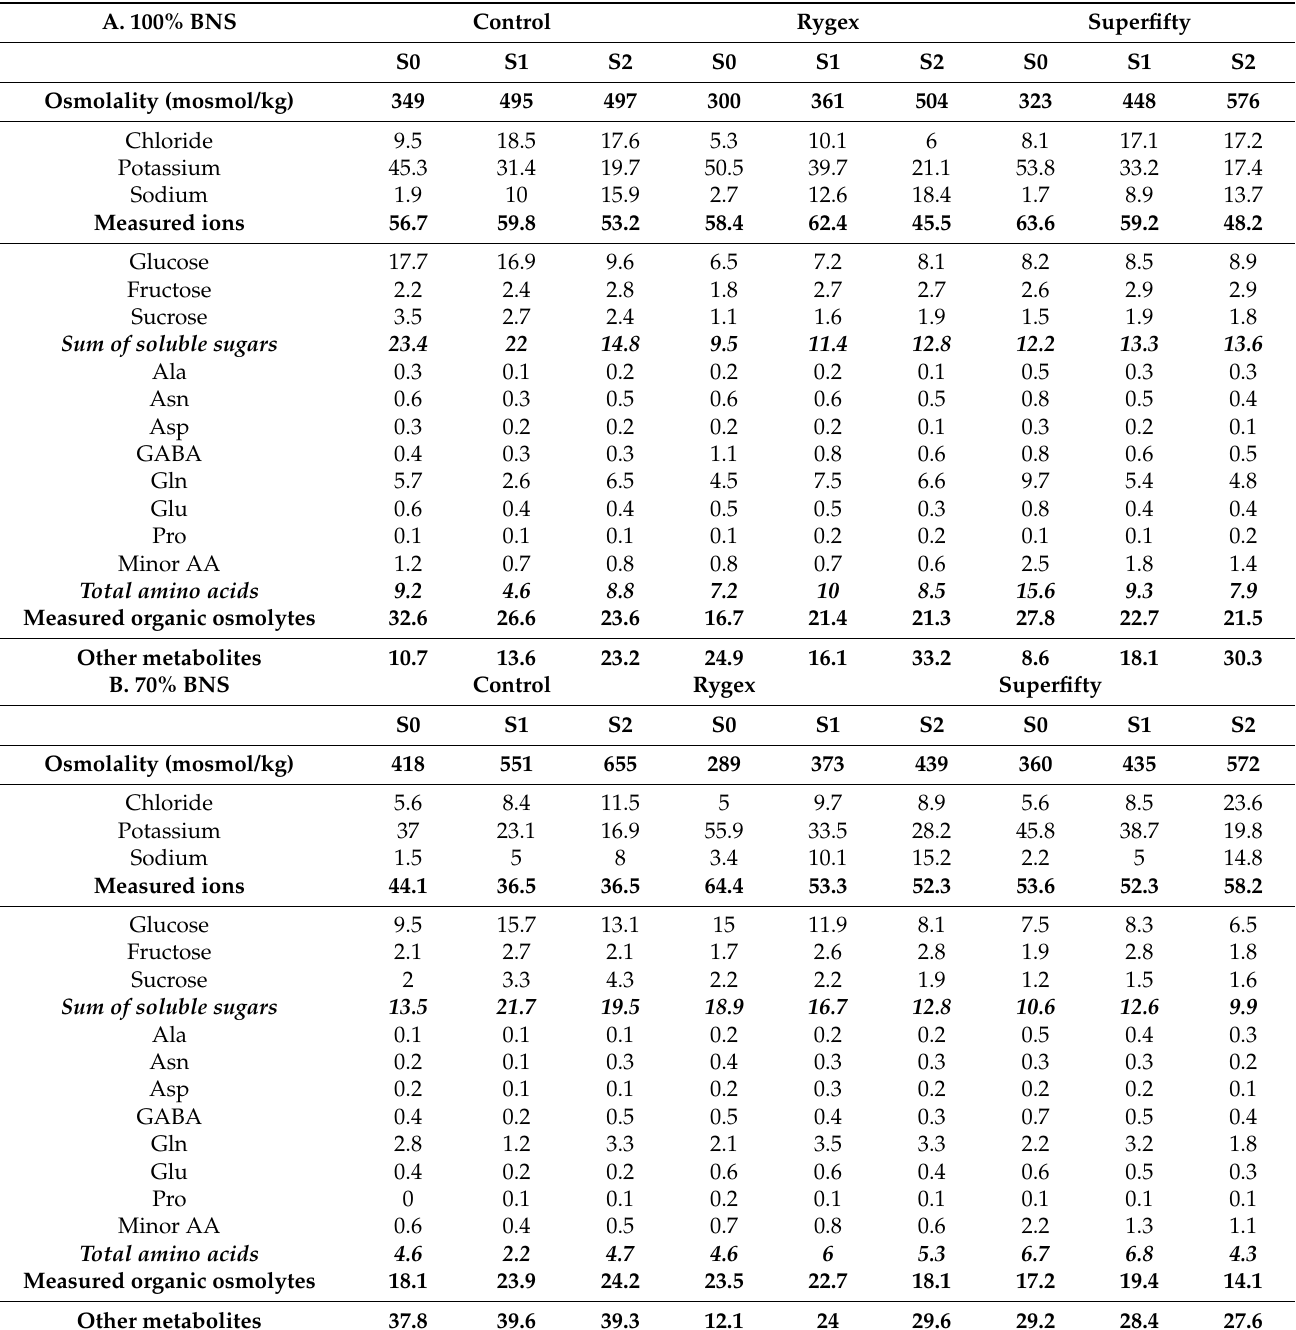
Table 6. Leaf osmolality and relative contribution (%) of inorganic ions, soluble sugars, amino acids and other metabolites towards the total osmolality of MicroTom plants. Experimental design is as in Table 1. The S.D. was lower than 15.8% of the average